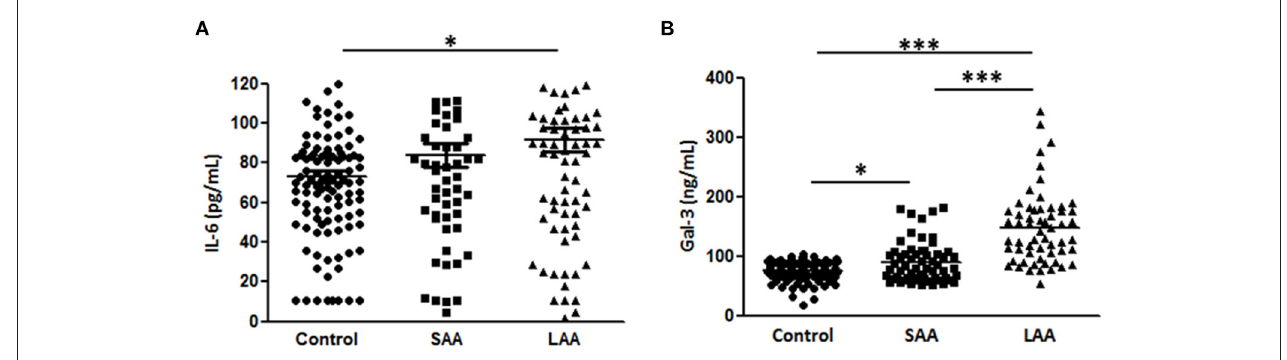
FIGURE 3 | Gal-3 and IL-6 levels according to aneurysm size. (A) Gal-3 and (B) IL-6 concentrations in plasma samples from patients with a normal aortic diameter (control, n = 195), small aortic aneurysm (SAA, n = 58), and large aortic aneurysm (LAA, n = 93). Data are expressed as mean ± standard error of the mean. * p < 0.05, *** p <